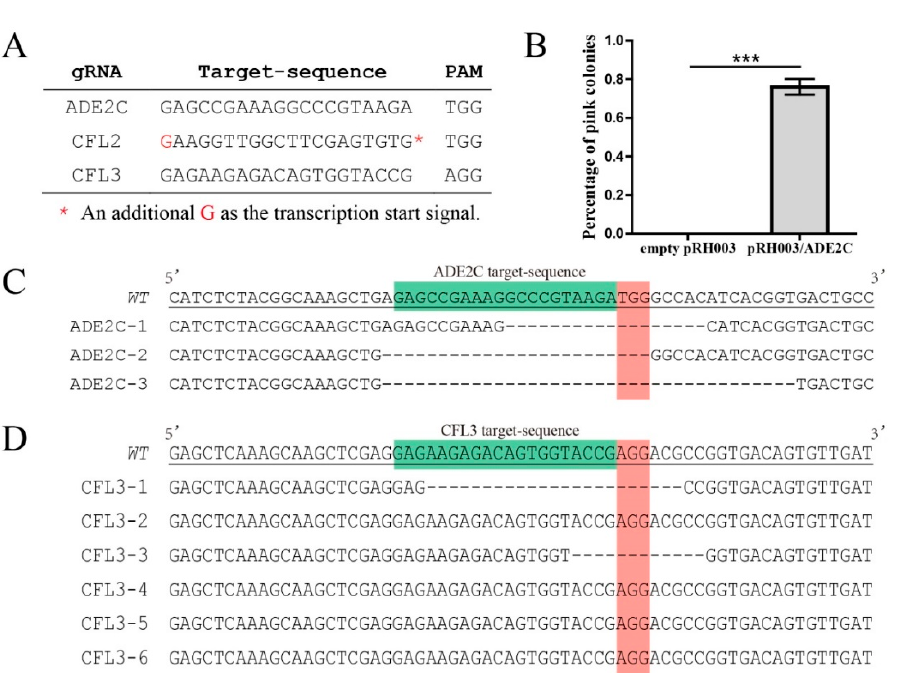
Figure 3. Target gene mutagenesis with the all-in-one CRISPR-Cas9 system expressed by the pRH003 vector. ( A ) Three target sequences and their PAM sequences are indicated. ( B ) The proportion of ADE2 mutants generated with pRH003/ADE2C. The CRISPR-Cas9 system could not target ADE2C locus without the guidance of gRNA carrying the ADE2C target sequence. Only the URA5 positive transformants containing gRNA, which carries the ADE2C target sequence, could form a large proportion of pink colonies. The boxes indicate the mean values, and error bars correspond to the SEM (three replicates per experiment). *** p < 0.001. ( C ) Alignments of the partial ADE2 gene sequences from three pink colonies transformed with linear pRH003/ADE2C. WT is the wild-type reference ADE2 gene sequence; ADE2C-1/-2/-3 are mutants from the population. Target and PAM sequences are highlighted. ( D ) Alignments of CFL3 gene from six randomly selected colonies transformed with linear pRH003/CFL3. Indels were detected in two out of the six transformants. WT is the wild-type reference CFL3 gene sequence; CFL3-1/-3 are mutants from the population. Target and PAM sequences are also highlighted.